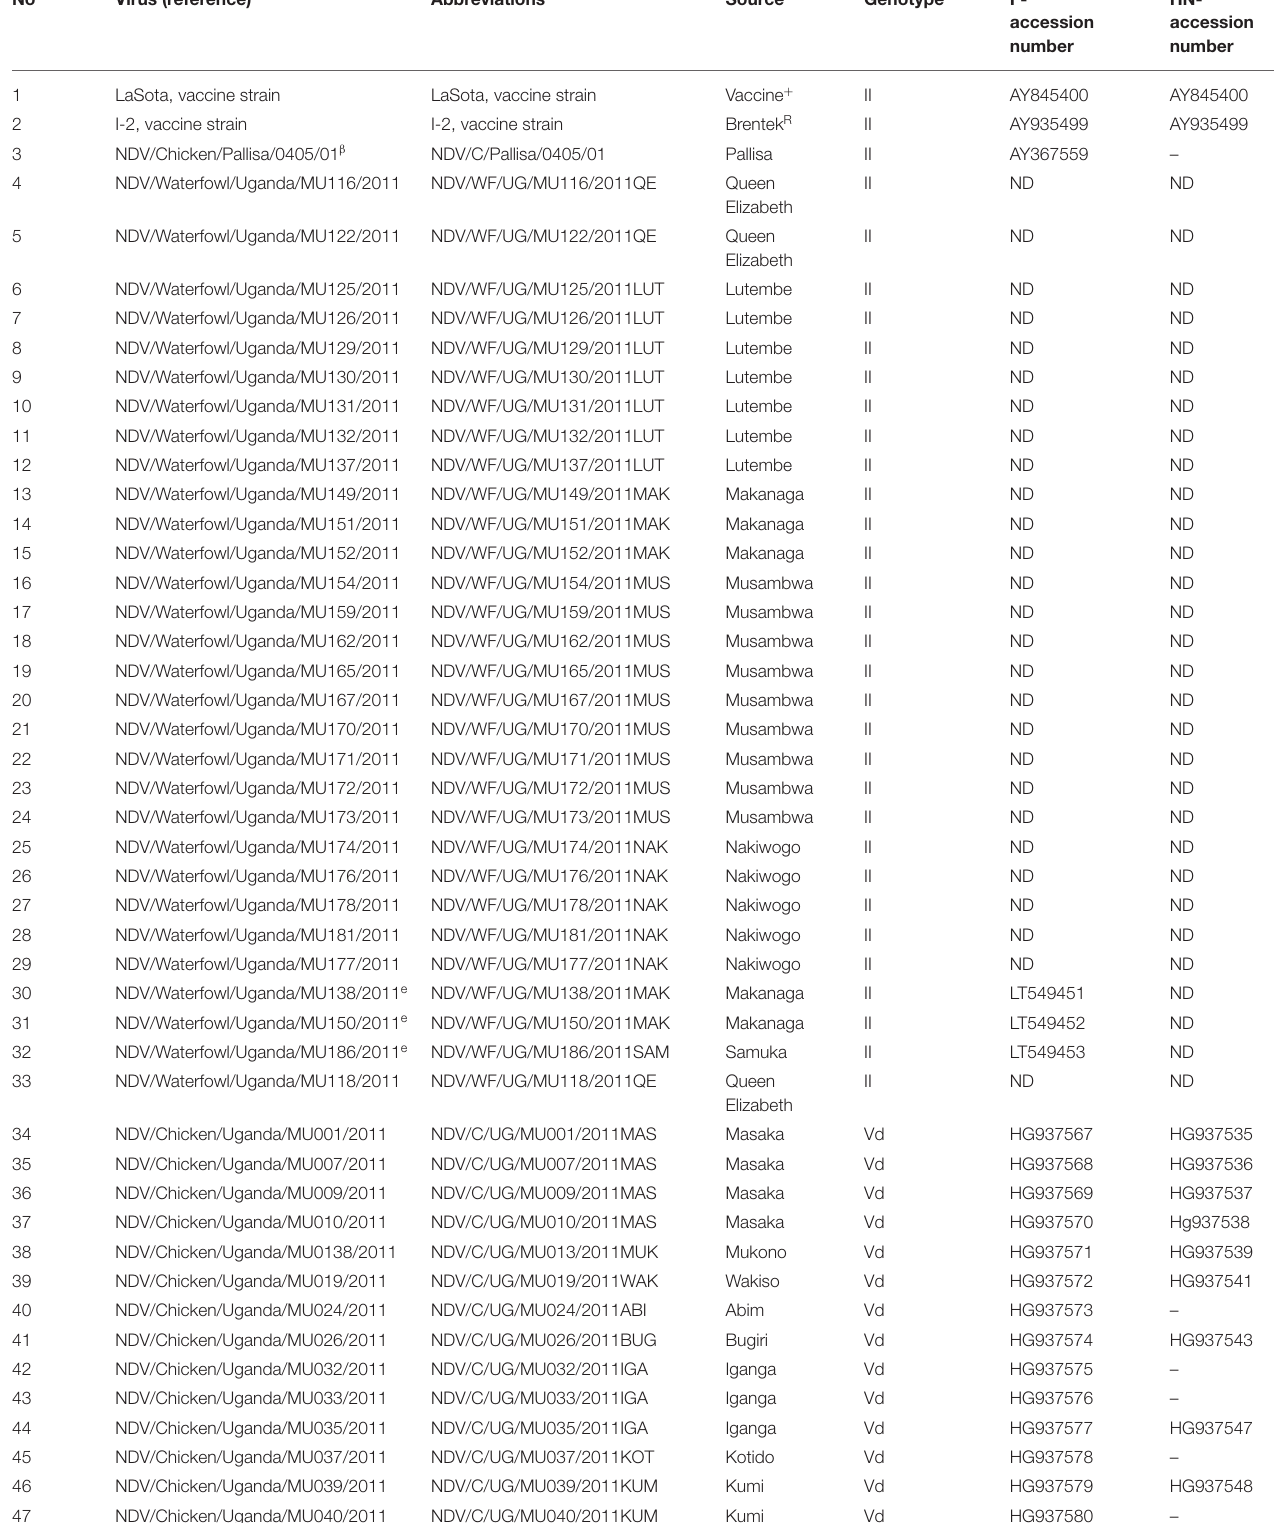
TABLE 1 | A list of Ugandan AAvV- 1 strains and reference vaccines used in this study.